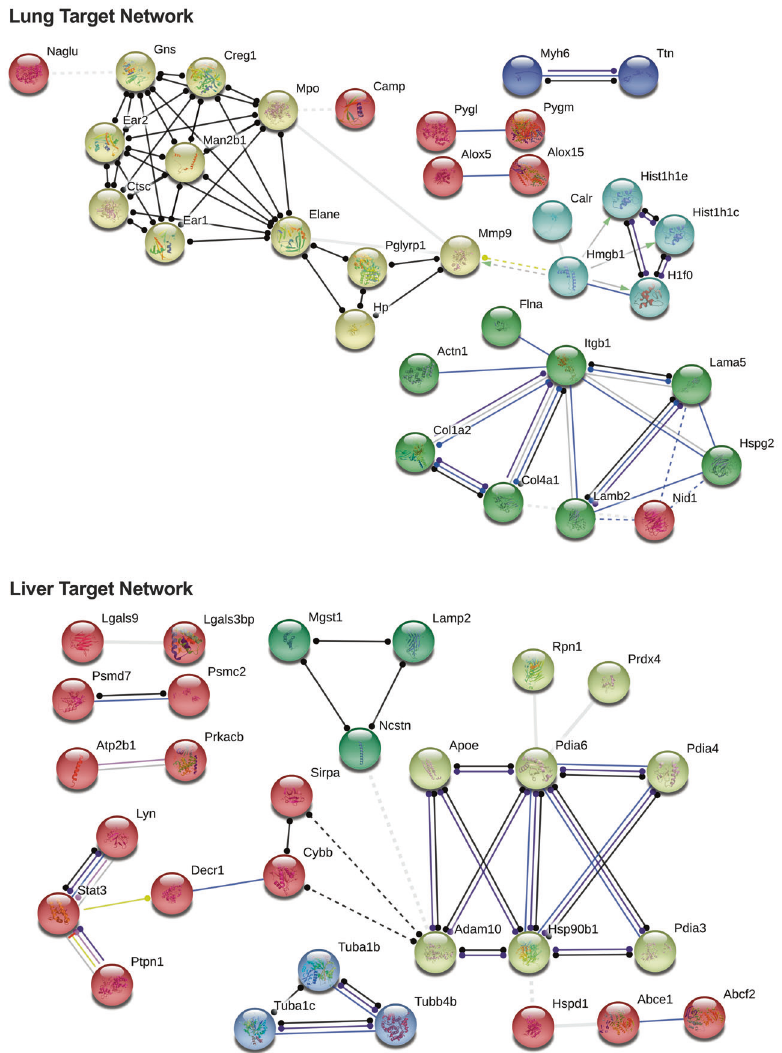
Fig. 4 STRING pathway analysis of LM and LuM CD11b + druggable proteomic targets. Druggable targets from the previous work fl ow were subject to pathway analysis using the data mining platform STRING. Nodes with multiple interactions within key pathways may serve as regulatory focal points of a given signaling